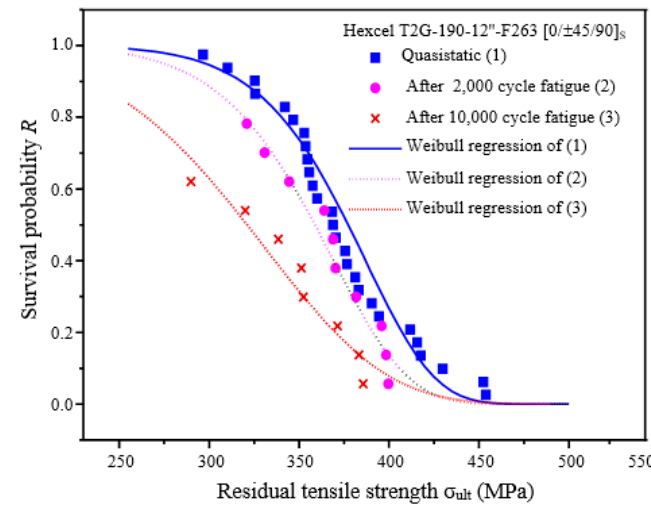
Figure 5. Variation of the survival probabilities with the residual tensile strength.